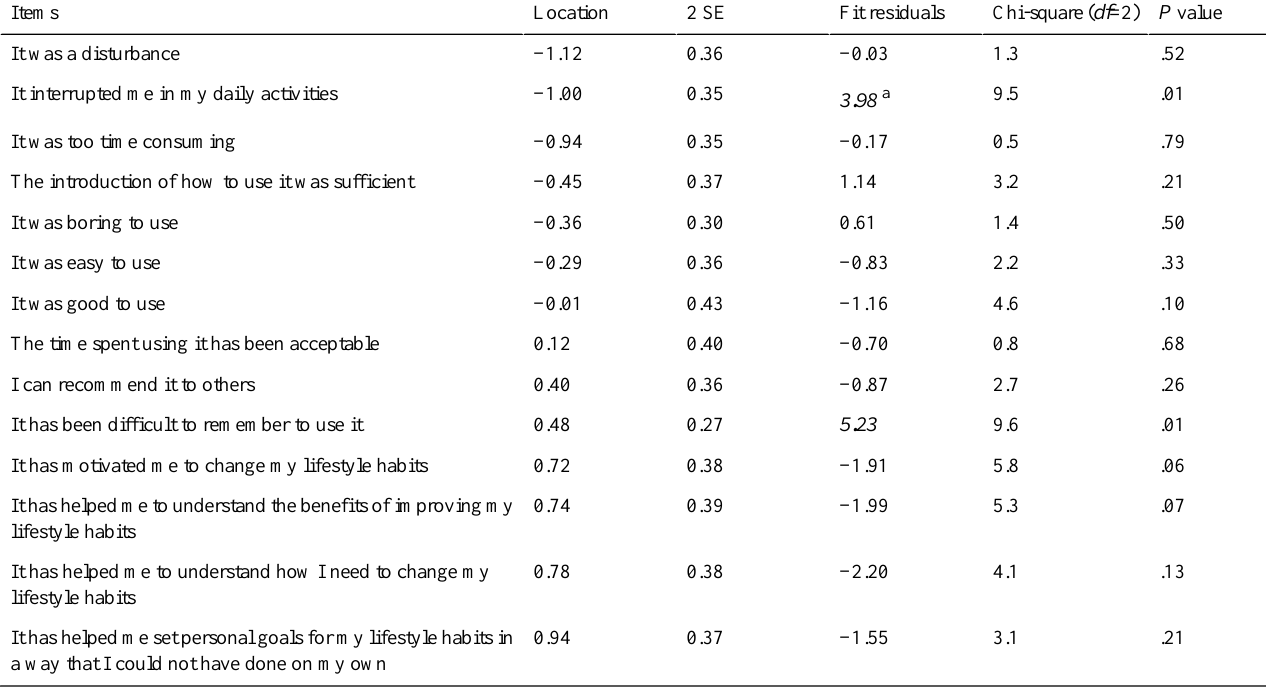
Table 1. Summary item statistics of the analyses for the version with 14 items.